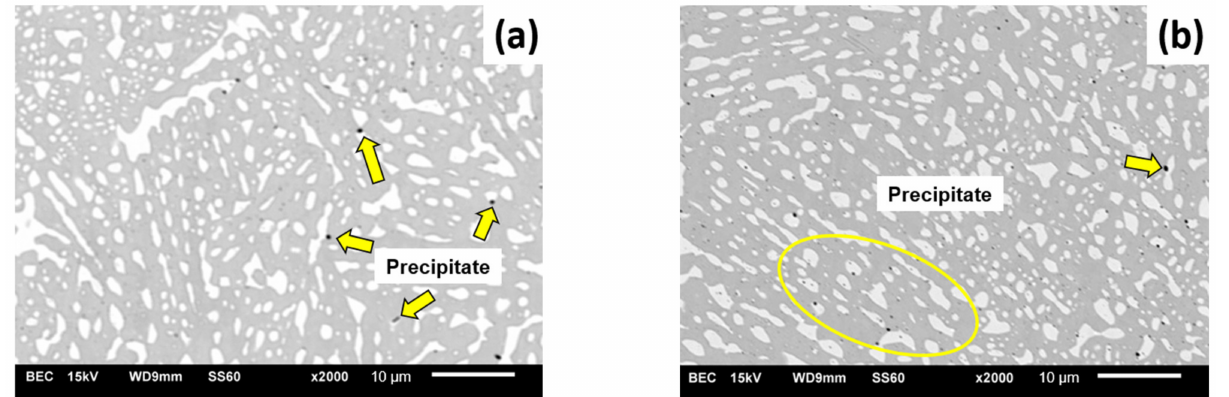
Figure 12. Microstructure of case 5 under ( a ) SEM-SE on the transverse plane, and ( b ) SEM-SE on the sagittal plane.